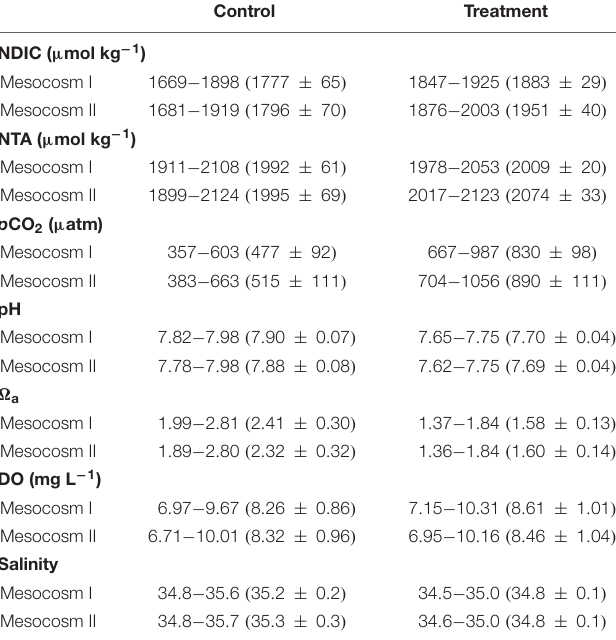
TABLE 1 | Summary of the variation ranges and means ± standard deviations of the salinity-normalized DIC (NDIC) and TA (NTA), p CO 2 , pH, (cid:127) a , DO and salinity in the replicate mesocosms over the course of the control and treatment periods.